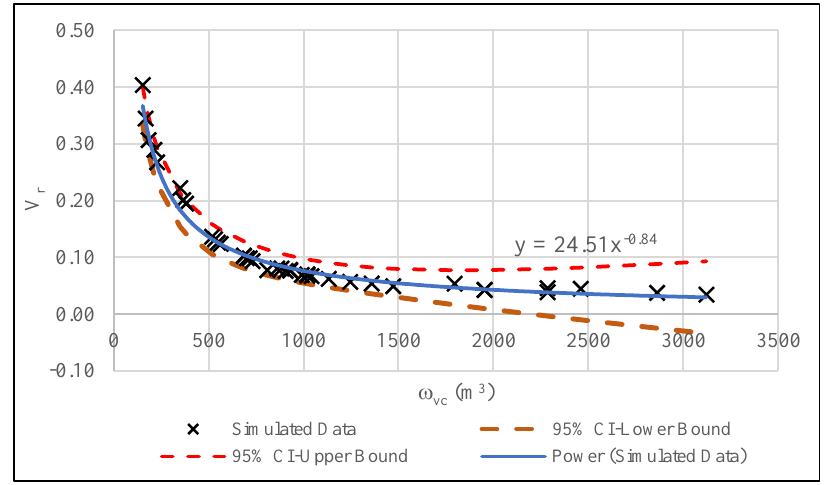
Figure 12. Relationship between V r against ω vc.